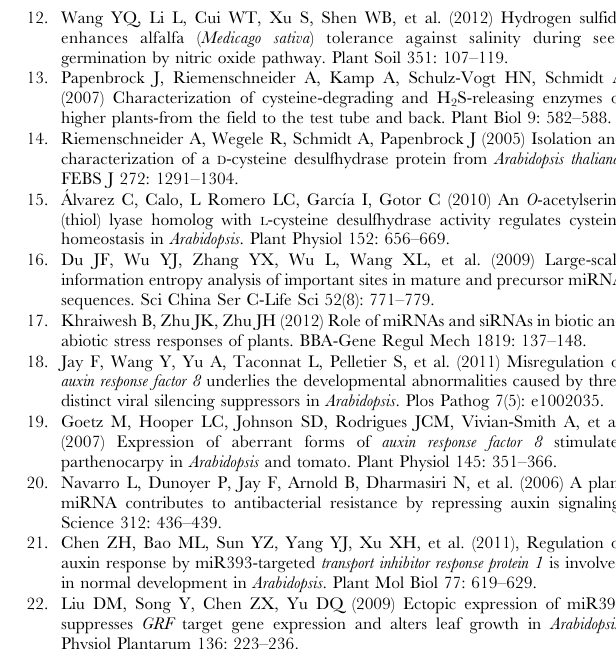
Table S1 List of all genes in the manuscript.